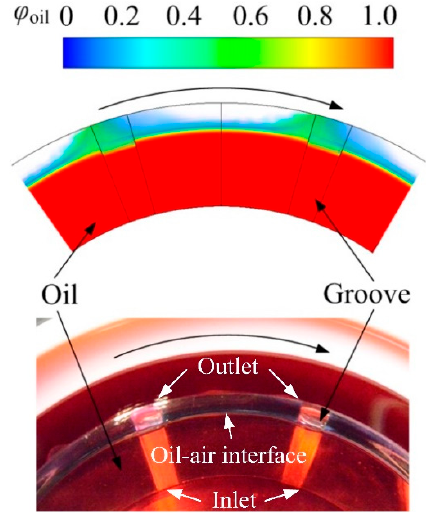
Figure 3. Comparison of the oil volume distribution between simulation and visualization test.